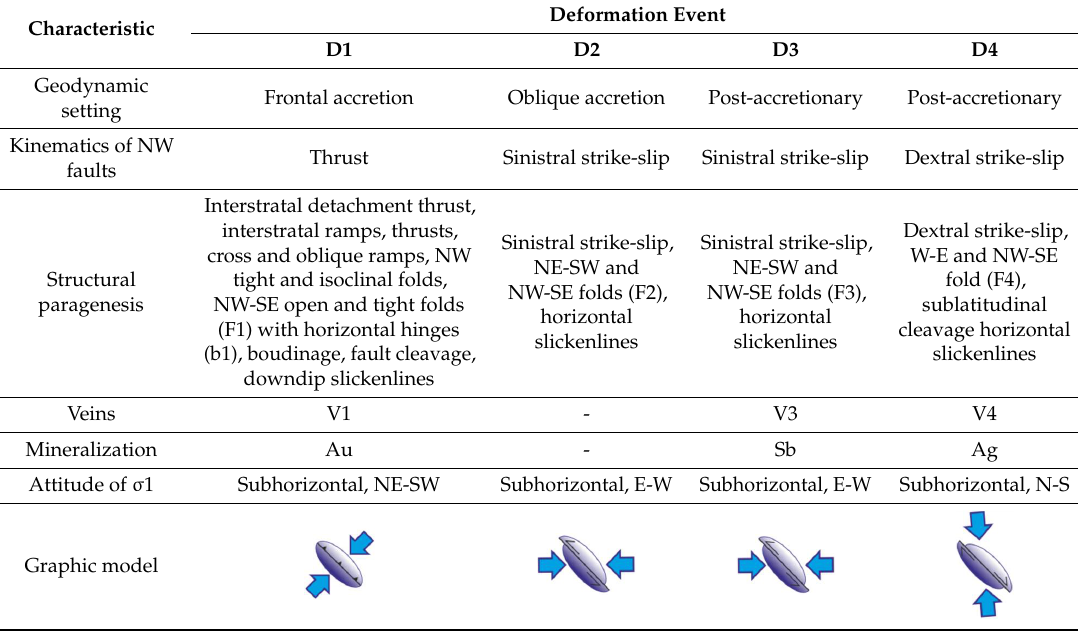
Table 1. Evolution of tectonic events and associated mineralization in the southwestern part of the Kular-Nera slate belt.